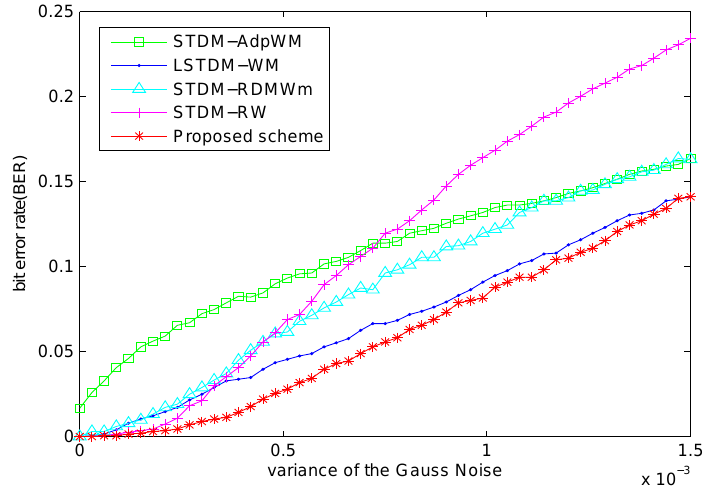
Figure 3. BER versus Gaussian noise for different watermarking algorithms with SSIM =